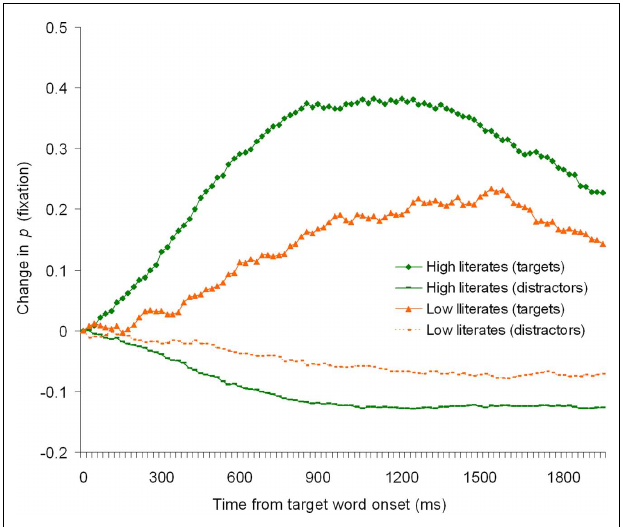
FIGURE 4 | Change in fixation proportions for the filler trials of Experiment 1.